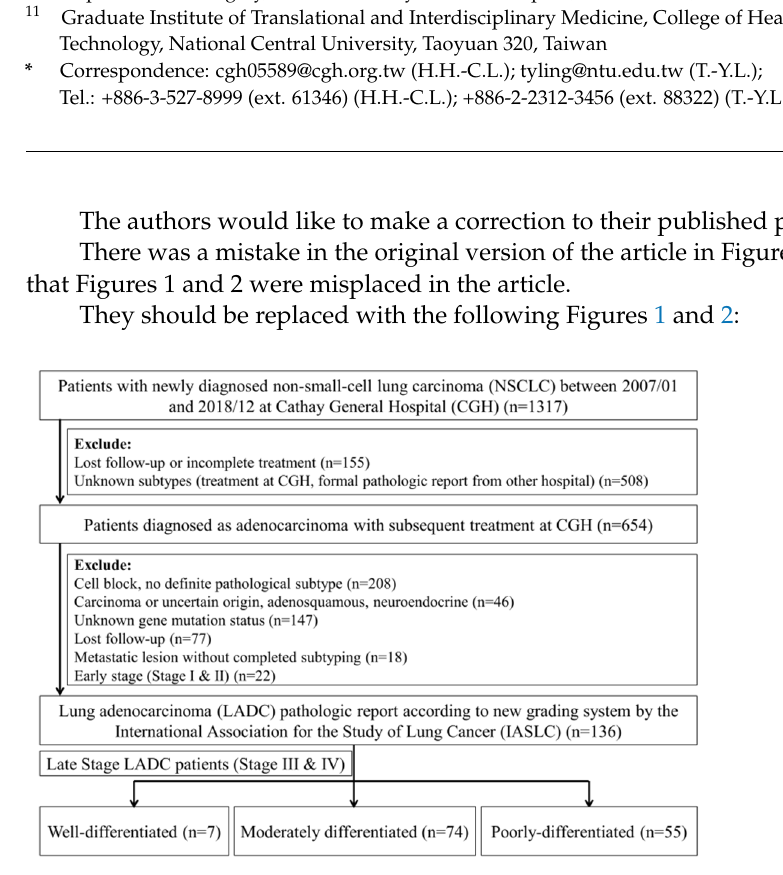
Figure 1. Selection criteria for the subjects.